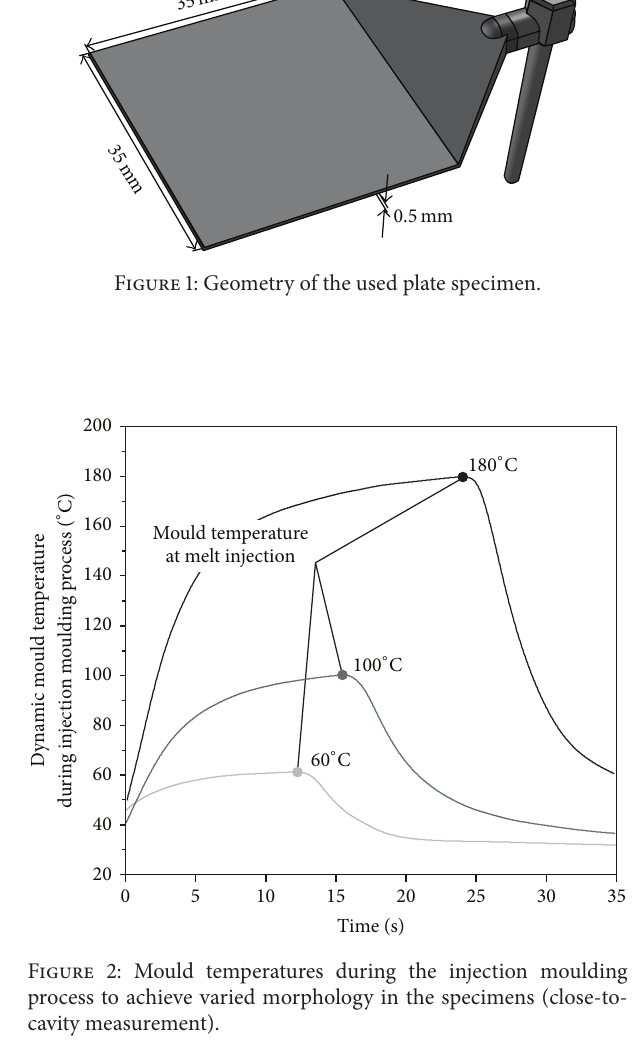
Table 1: Material properties (manufacturer’s data).